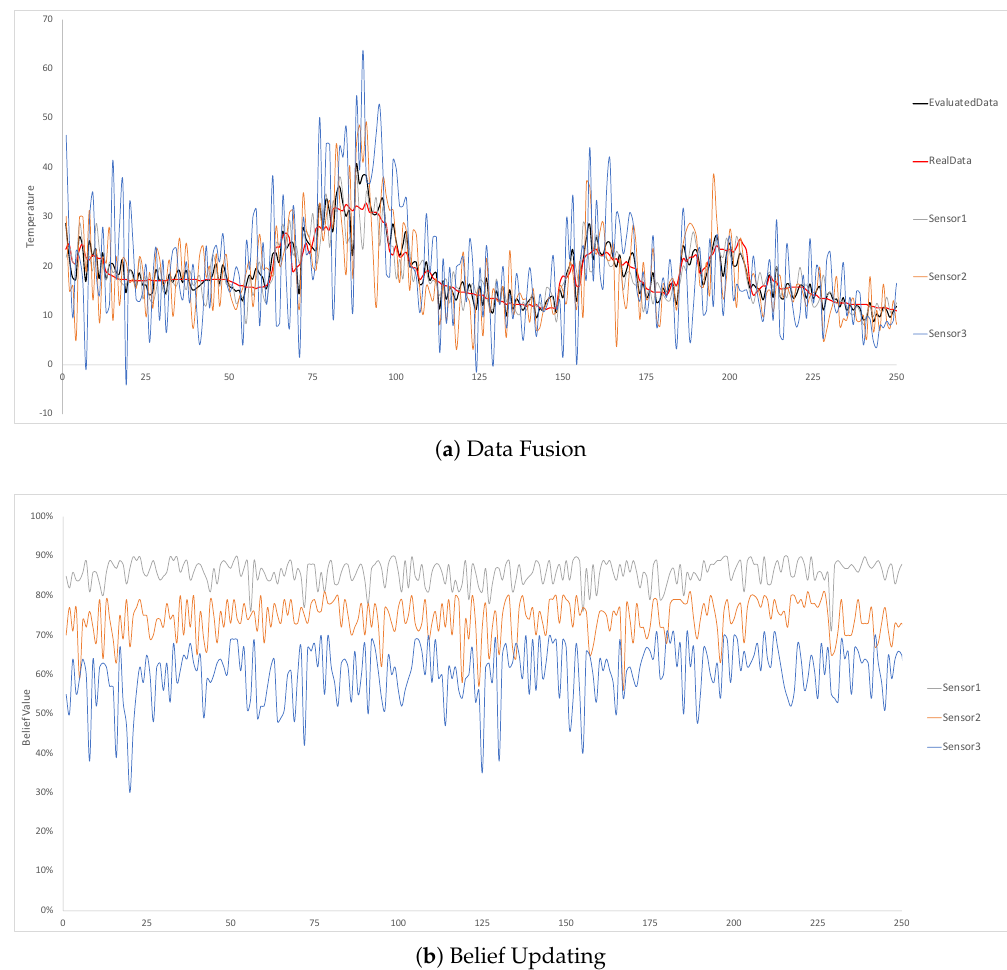
Figure 10. Three static temperature sensors at location 1 with 85%, 70% and 55% belief setting for each sensor,